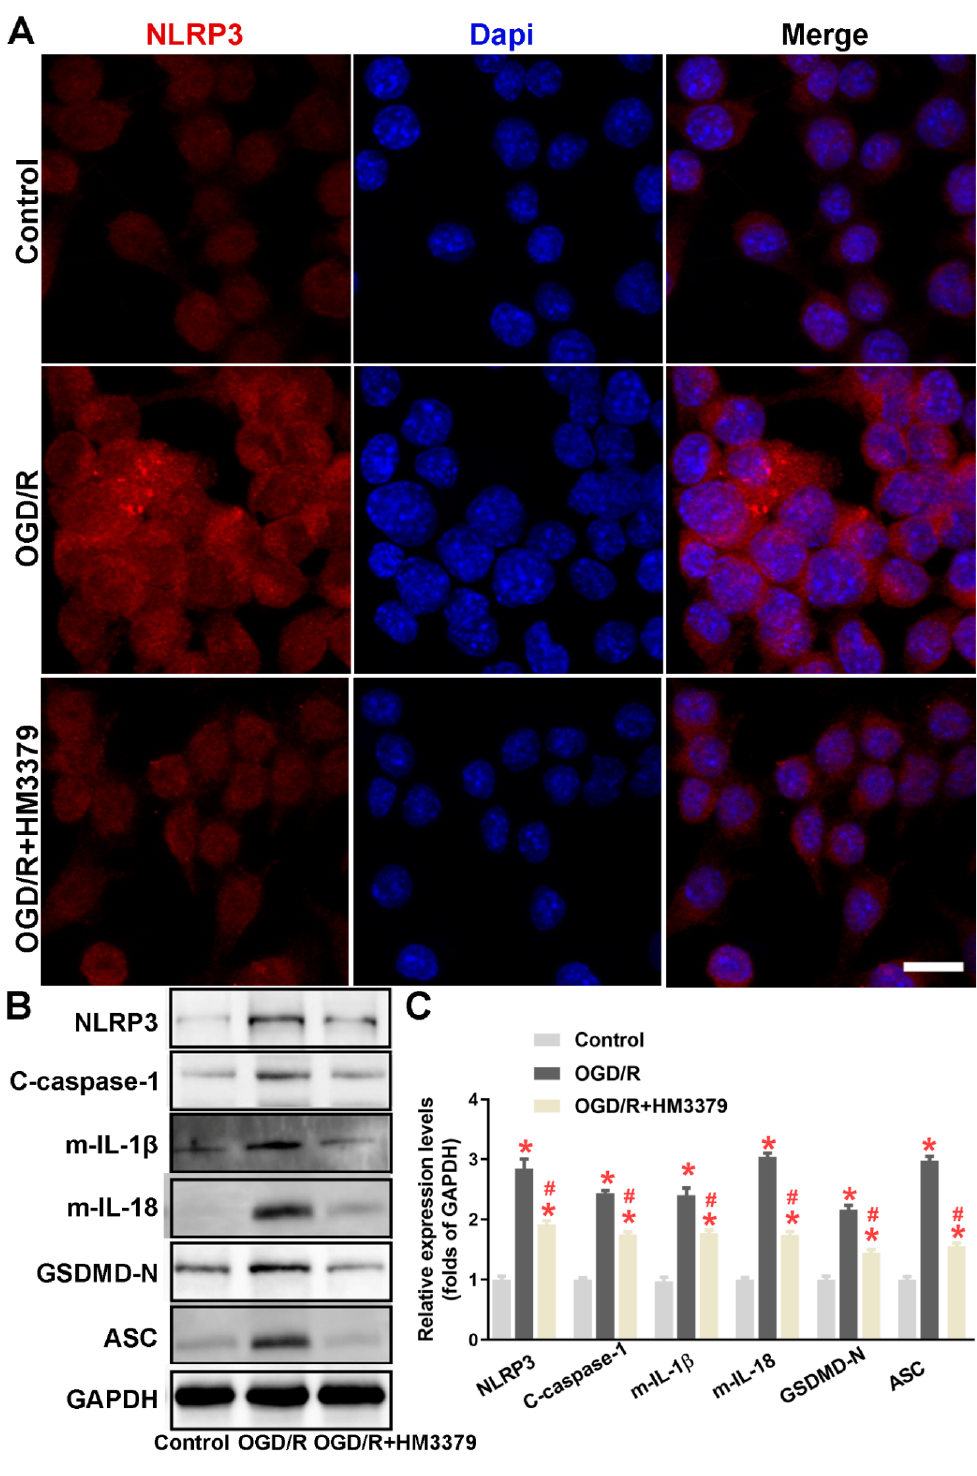
Figure 4. H3379 suppressed OGD/R-induced NLRP3 inflammasome activation and pyroptosis in BV2 cells. ( A ) NLRP3 (red) immunofluorescence staining results showed that HM3379 decreased the intensity of NLRP3-positive cells when exposed to the OGD/R condition. ( B ) The expressions of NLRP3, cleaved caspase-1, mature IL-1 β , mature IL-18, GSDMD-N, and ASC in the indicated groups were determined by Western blot. ( C ) Combined Western blot statistics. Data are presented as mean ± SEM. * indicates p < 0.05 vs. control, # indicates p < 0.05 vs. OGD/R. N = 3 per group. Scale bars = 50 µ m. OGD/R, oxygen glucose deprivation/